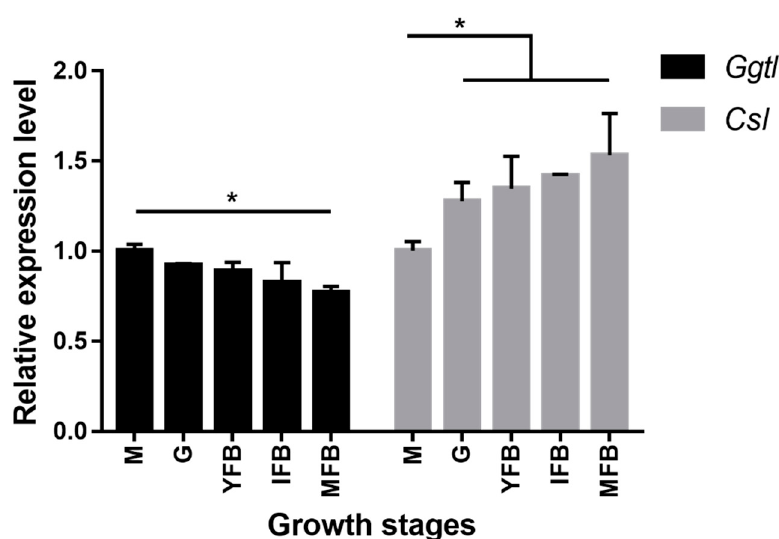
Figure 2. Expression of Ggtl and Csl during fruit-body development of Lentinula edodes strain W1. Relative expression during five growth stages, M, mycelia; G, grey; YFB, young fruiting body; IFB, immature fruiting body; MFB, mature fruiting body. Transcript levels of Ggtl (black bars) and Csl (gray bars) were determined by real-time quantitative RT-PCR analysis and normalized against Actinl . The expressions during the M stage were taken as 1. Error bars indicate standard deviation for three independent experiments. * p < 0.05, ANOVA tests by Duncan’s indicate significant differences.